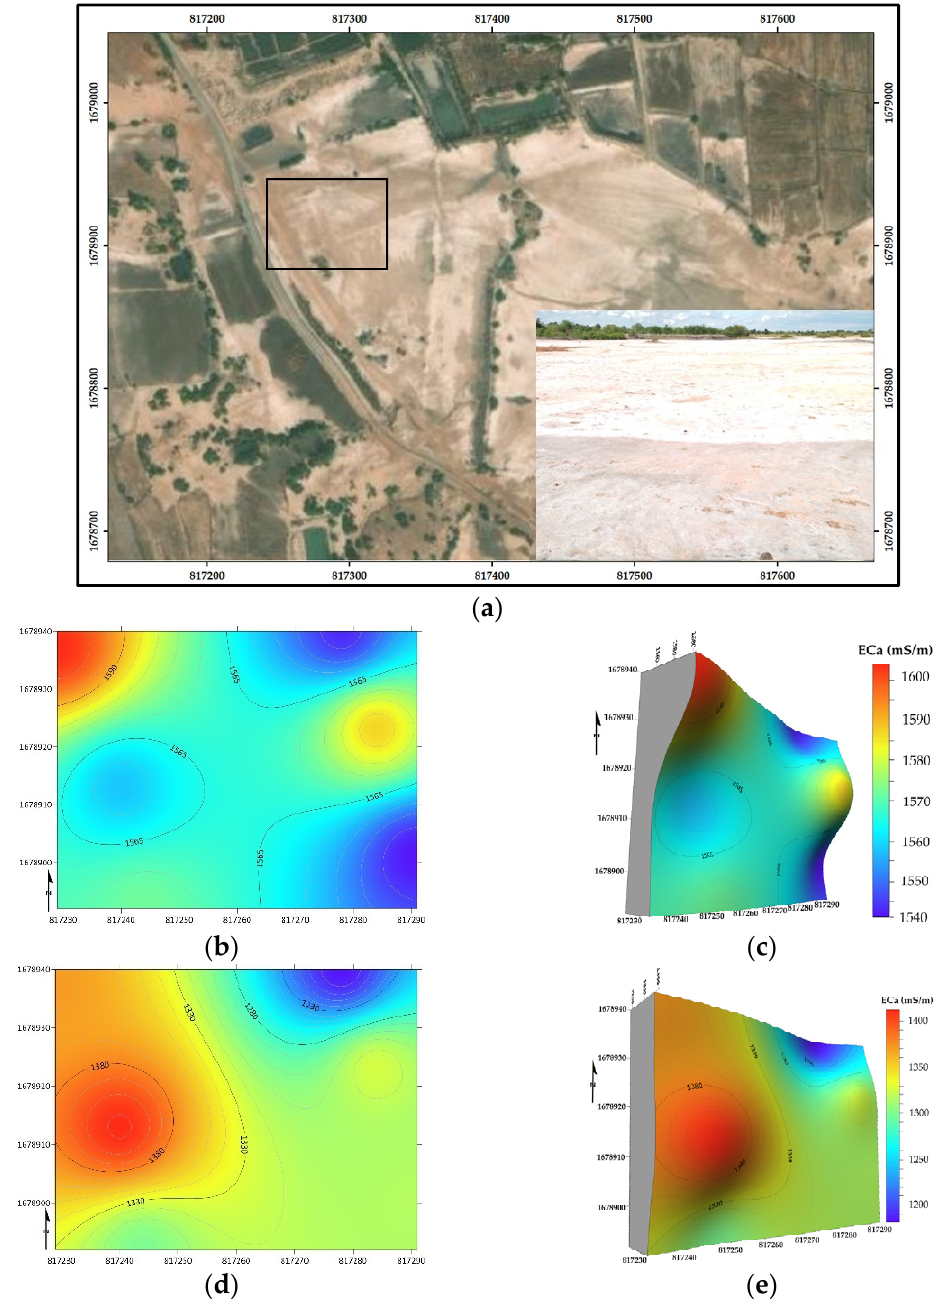
Figure 6. Field photograph and 2D and 3D maps of HH and VV modes over salt patches at Ban Don Nam Sai, Ban Wang sub-district. ( a ) Salt patches. ( b ) 2D-ECa (HH). ( c ) 3D-ECa (HH). ( d ) 2D-ECa (VV). ( e ) 3D-ECa (VV).